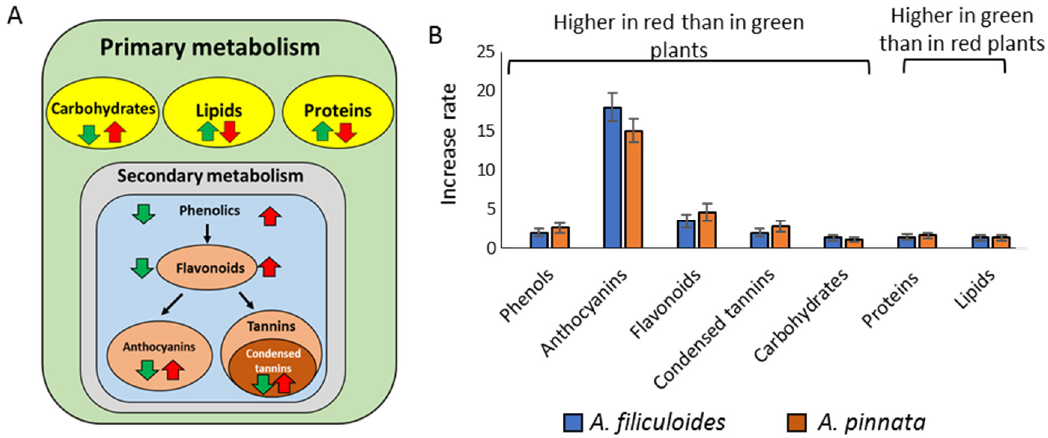
Figure 5. ( A ) Representation of differential accumulation of cellular primary (carbohydrates, lipids, and proteins) and secondary (phenolics, anthocyanins, flavonoids, and condensed tannins) metabolites in red (red arrow) and greed (green arrow) plants; ( B ) comparative increase rates (fold increase, p < 0.05) in production of metabolites between red and green Azolla plants. Supplementary Materials: The following are available online at www.mdpi.com/xxx/s1, Figure S1: (A) A. filiculoides green (a) and red (b) grown outdoors. (B) A. pinnata green (a) and red (b) grown outdoors. Figure S2. (A) Longitudinal sections of A. filiculoides plants. (B) Nostoc azollae in leaf cavities shown by arrow.